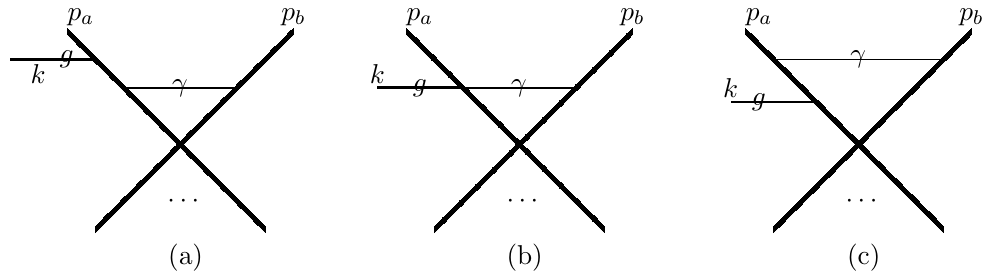
Figure 17 . Contribution to soft graviton amplitude due to internal photon whose two ends are con- nected to two di(cid:11)erent scalar lines. Here the thickest lines denote scalars, lines of medium thickness carrying the symbol g denote gravitons and the thin lines carrying the symbol (cid:13) denote photons.